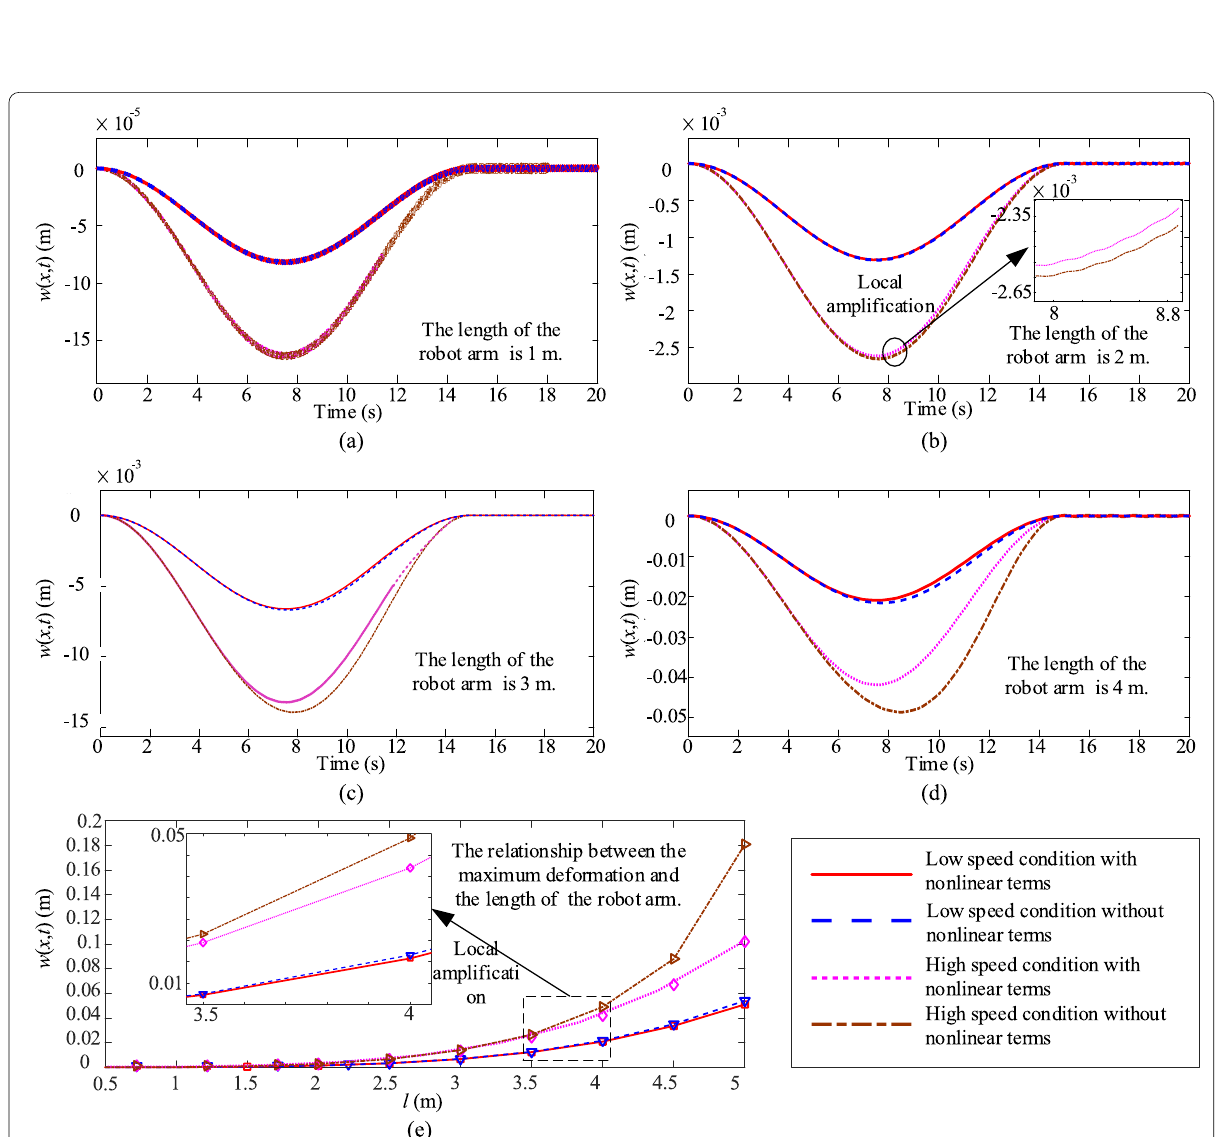
Figure 10 Influence of the manipulator’s length on maximum deformation: ( a ) Simulation results when the length is 1 m, (b) Simulation results when the length is 2 m, ( c ) Simulation results when the length is 3 m, ( d ) Simulation results when the length is 4 m, ( e ) Relationship between maximum deformation and